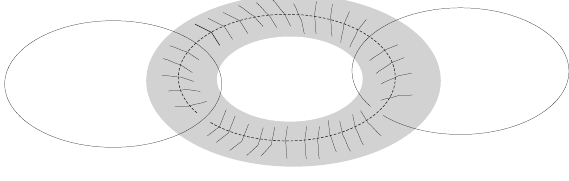
Figure 2 - A dicritical component of (cid:101) F